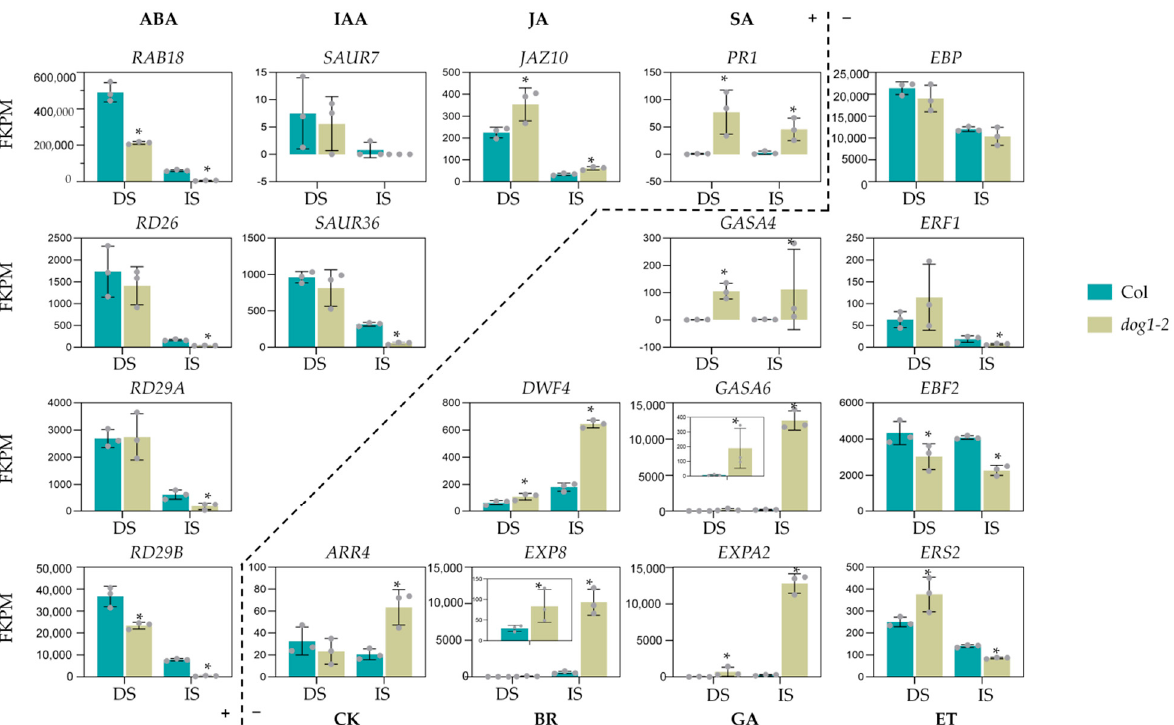
Figure 6. DOG1 differentially regulates the endogenous signal intensity of different phytohormones. FKPM value shows the relative expression level of representative marker genes of the indicated phytohormone pathway in Col and dog1–2 seeds. DS, dry seeds; IS, imbibed seeds. The dashed line divides the phytohormones into two classes: “+” denotes the phytohormones that induce seed dormancy or inhibit seed germination; “ − ” denotes the phytohormones that release seed dormancy or promote seed germination. *, p < 0.05.